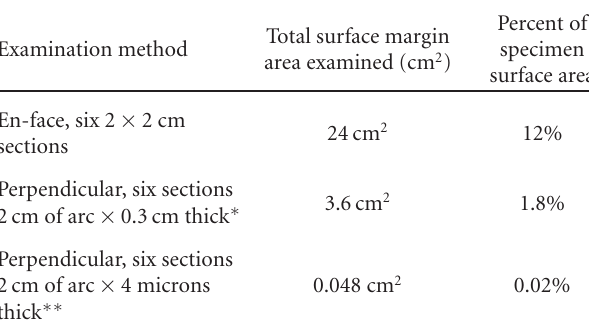
Table 4: Percent of surface area available for conventional his- topathologic evaluation of surgical margin status. Hypothetical 8.0cm diameter lumpectomy specimen with one 2.0cm × 2.0 cm tissue block removed for each of six axial margins. Specimen surface area = 201cm 2 .